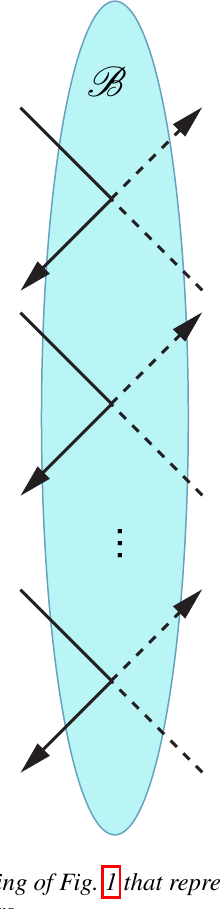
Figure 7: Re-drawing of Fig. 1 that represents areal elements as scattering